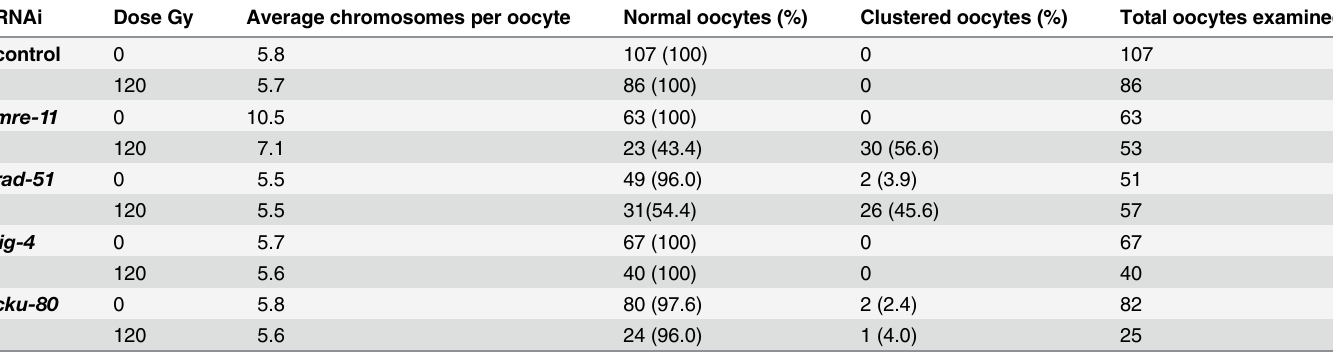
Table 2. Knockdown of HDR genes results in abnormal morphology in C . elegans oocytes. RNAi Dose Gy Average chromosomes per